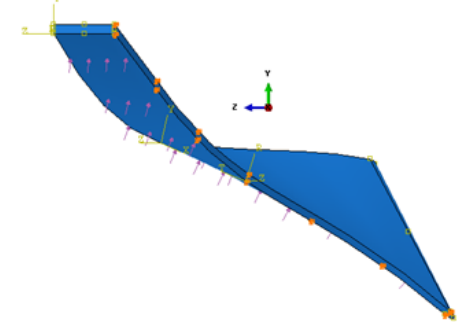
Figure 6: Loading and boundary